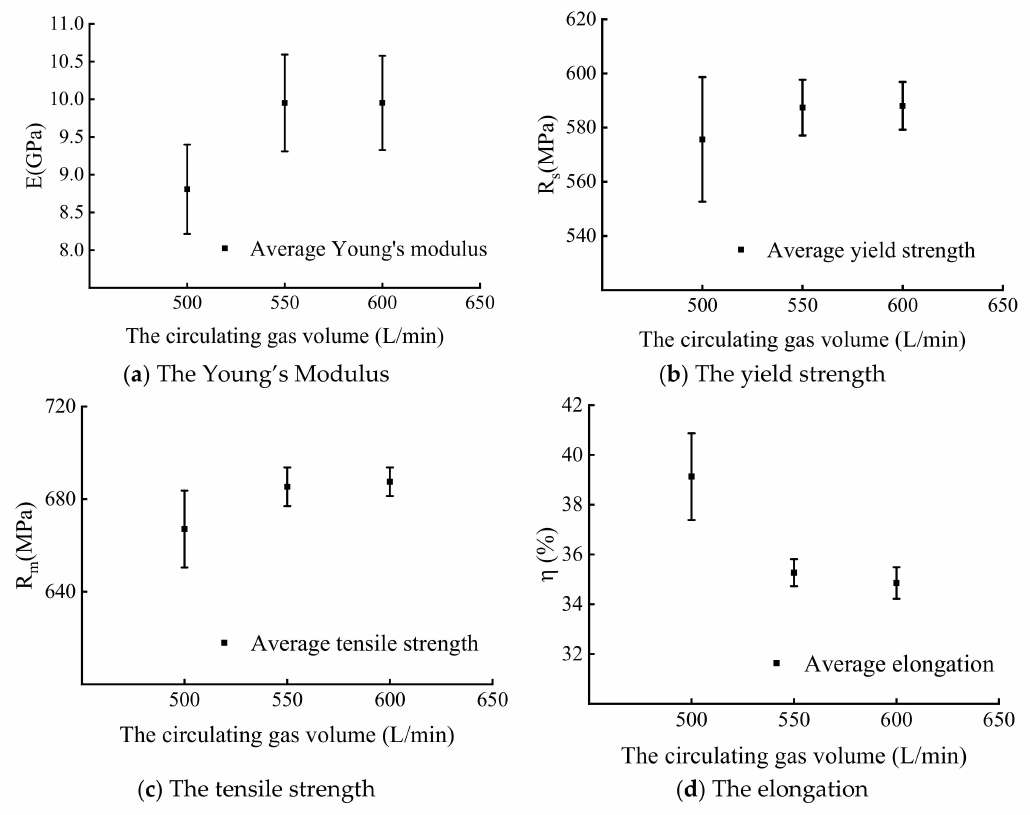
Figure 10. The average elongation and tensile strength with error bars of each set.